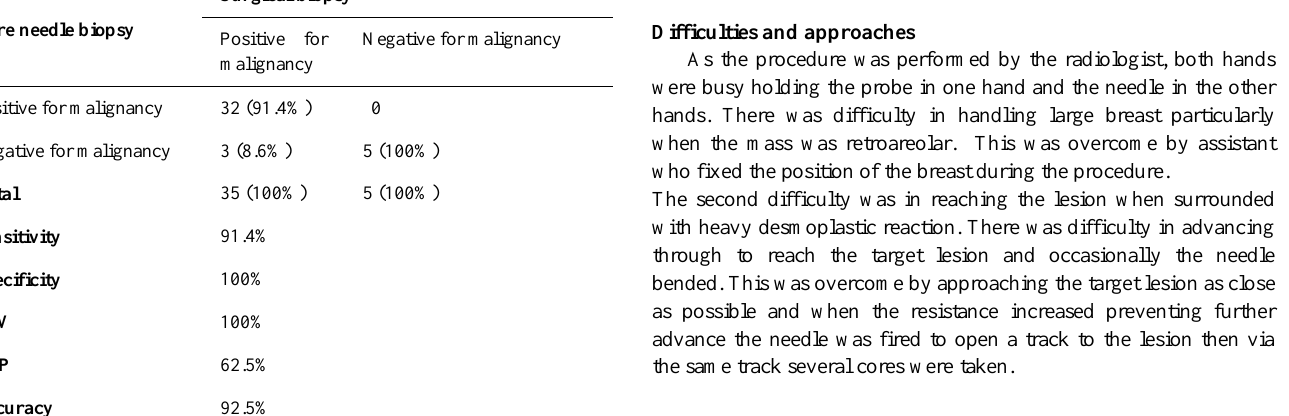
Surgical biopsy